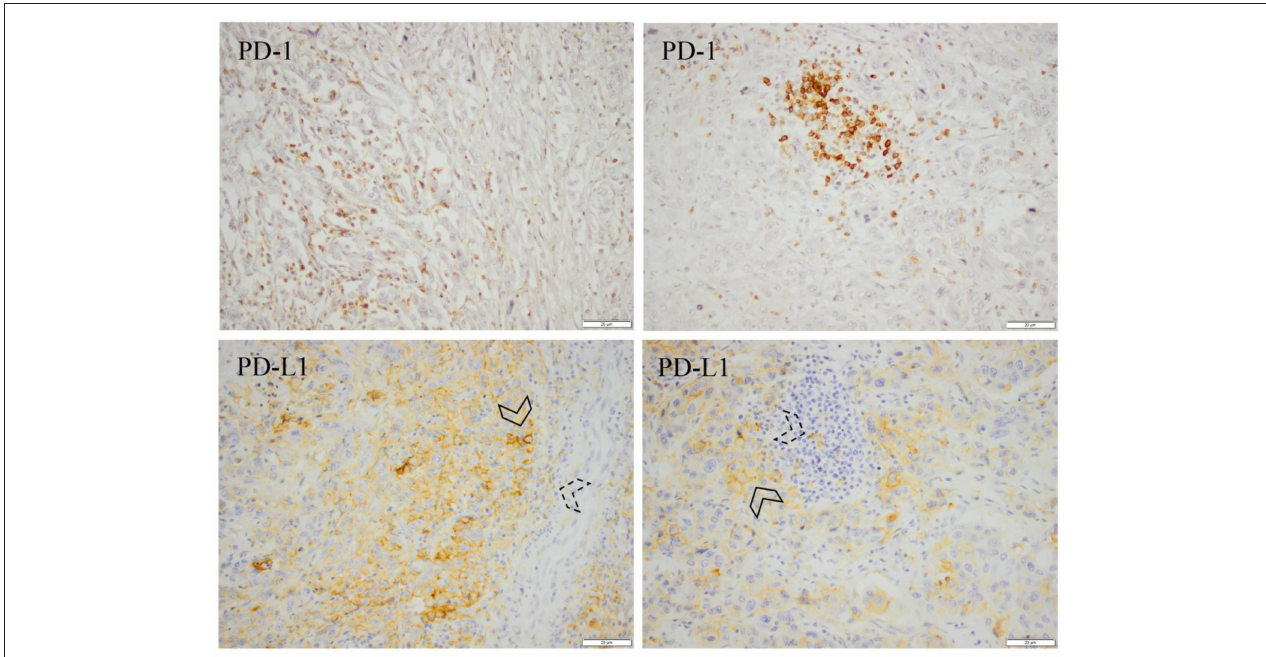
FIGURE 1 | Immunohistochemical expression of PD-1 and PD-L1 in the primary tumour (left) and a paired lymph node metastasis (right) from an esophageal (cardia Siewert 1) pT3N3M0 tumour. PD-1 and PD-L1 positivity was denoted in > 50% of the immune cells, and PD-L1 positivity was denoted in > 50% of the tumour cells. Arrowheads with solid lines denote PD-L1 positive tumour cells and arrowheads with dashed lines denote PD-L1 positive immune cells. In general, PD-L1 positive immune cells in the lymph nodes were located in the vincinity of the metastatic deposits.